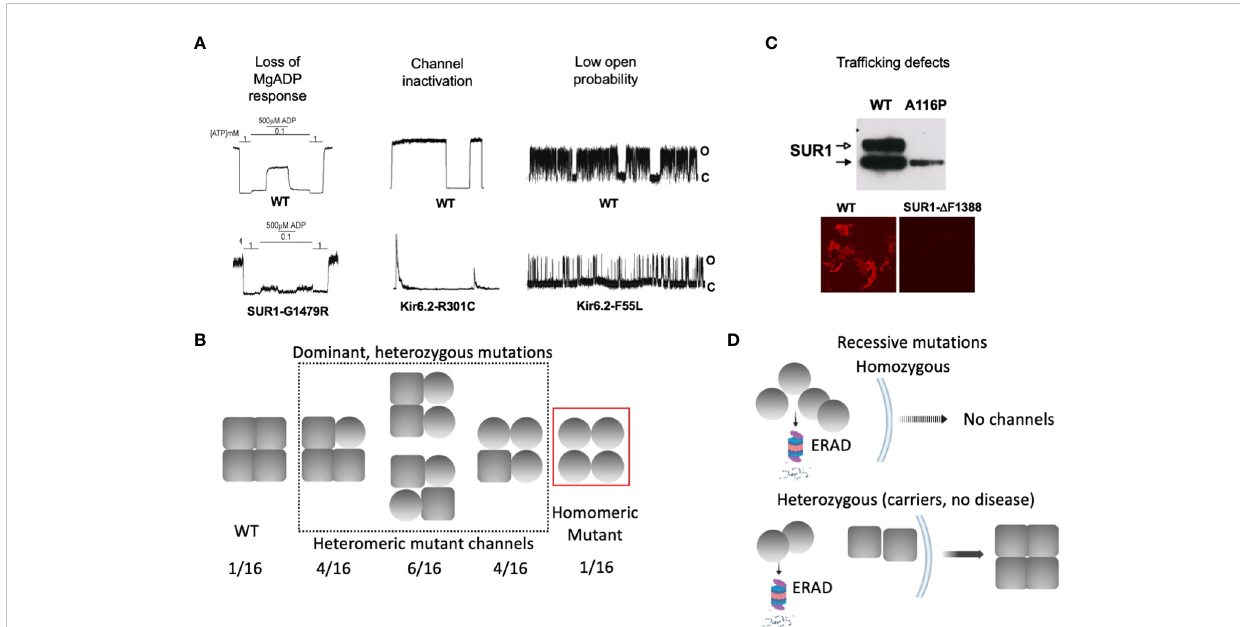
FIGURE 3 Biochemical and functional characteristics of K ATP channel mutations associated with dominant versus recessive diffuse CHI. (A) Gating defects that have been observed in CHI-associated mutations, including loss of MgADP response, spontaneous current decay. i.e. channel inactivation, and reduced channel open probability. For each defect, representative inside-out patch-clamp recordings of WT and homomeric mutant channels are shown. For monitoring MgADP response, channels were exposed to 1 mM ATP, 0.1 mM ATP, or 0.1 mM ATP plus 0.5 mM MgADP as indicated. In all recordings, channel openings (O) are shown as upward de fl ections, and channel closures (C) as fl at baselines. (B) Schematic showing that gating mutations tend to be associated with dominant disease, where heterozygous patients are expected to express a mixed population of channels containing 0-4 mutant subunits. In these cases, the mutation causes gating defects but not defects in channel folding, assembly, and traf fi cking. (C) Top : A western blot showing both core-glycosylated and complex-glycosylated wild-type SUR1 band when co-expressed with Kir6.2, indicating channel assembly and ability to traf fi c to the cell surface. In contrast, a traf fi cking mutation SUR1-A116P, fails to generate the mature complex- glycosylated band. Bottom : Surface immuno fl uorescence staining showing lack of expression of a traf fi cking mutant SUR1- D F1388, in contrast to WT. (D) Schematic showing traf fi cking mutations are usually seen in recessive disease. In patients carrying homozygous mutations, mutant protein is targeted for ER-associated proteasomal degradation (ERAD) and is unable to form channels and traf fi c to the plasma membrane. In heterozygous individuals, mutant protein is degraded and unable to assemble with WT subunit, leaving WT protein to assemble into functional channels that traf fi c to the plasma membrane, escaping the